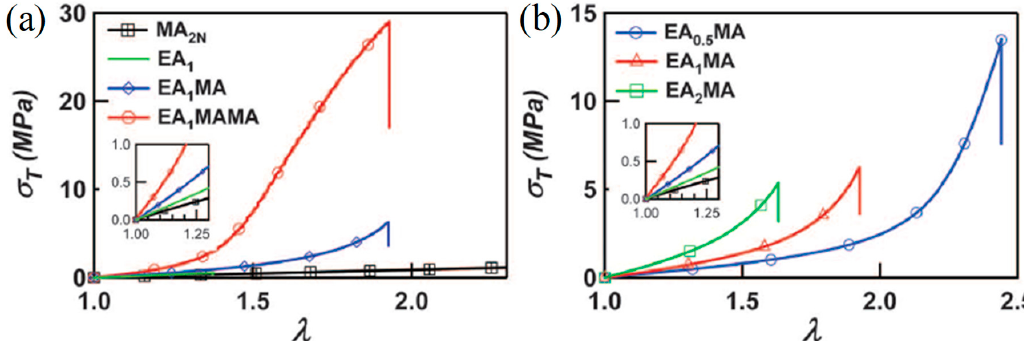
Figure 4. Mechanical behavior of the single network (SN), double-network (DN) and triple-network (TN) elastomers. ( a ) True stress–stretch curves for the EA 1 , EA 1 MA, EA 1 MAMA and PMA second network alone at 60 °C. ( b) Effect of the cross-linker loading in the EA first network on the EA x MA DN elastomers. EA: ethyl acrylate; MA: methyl acrylate. Adapted and reprinted with permission from [17]. Copyright 2014 American Association for the Advancement of Science.